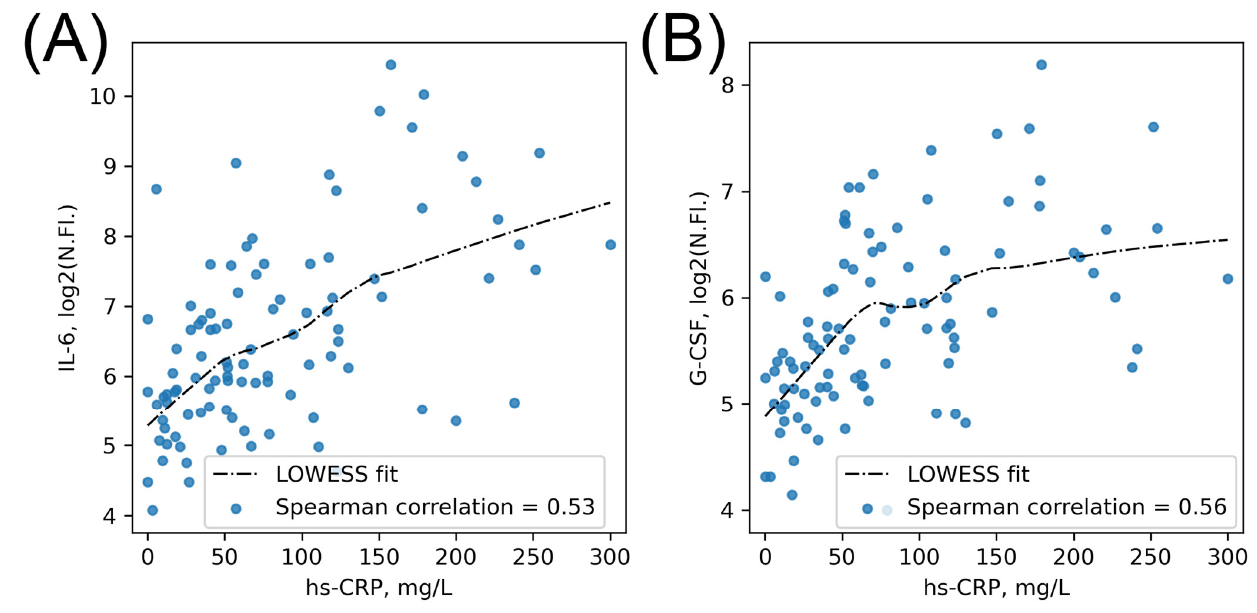
Figure 4. Correlation of cytokine levels at timepoint 1 with CRP level. Il-6 vs hs-CRP ( A ). G-CSF vs hs-CRP ( B ). Data are presented as log2 of the normalized fluorescence values with the Spearman correlations.